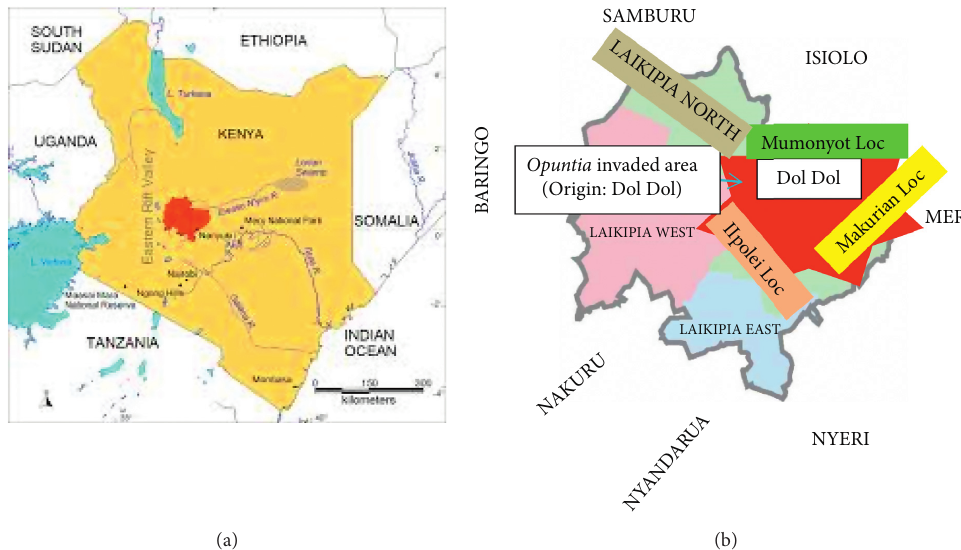
Figure 2: Map of Kenya showing the location of Laikipia County (a). Map of Laikipia County showing three locations in Laikipia North sub- County invaded by Opuntia stricta (b).